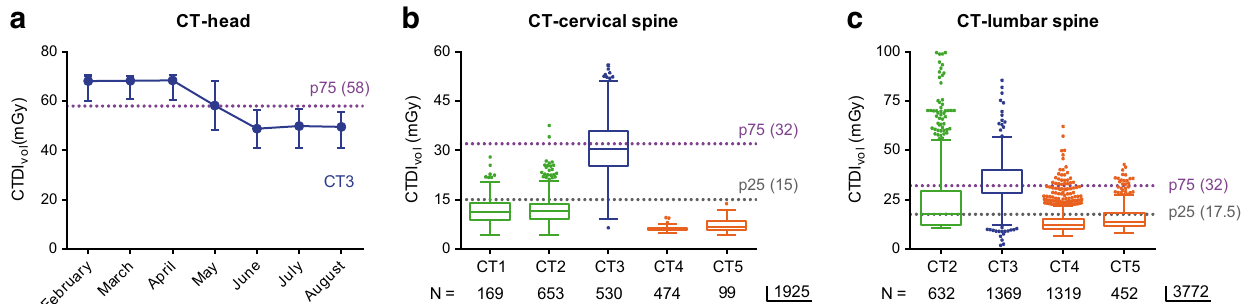
range and outliers for all CT-cervical spine examinations on the five CT systems with the national P75 and P25 DRLs as benchmark. c Box plot of the CTDI vol -median value, interquartile range, total range and outliers for all CT-lumbar spine examinations on four CT systems with the national P75 and P25 DRLs